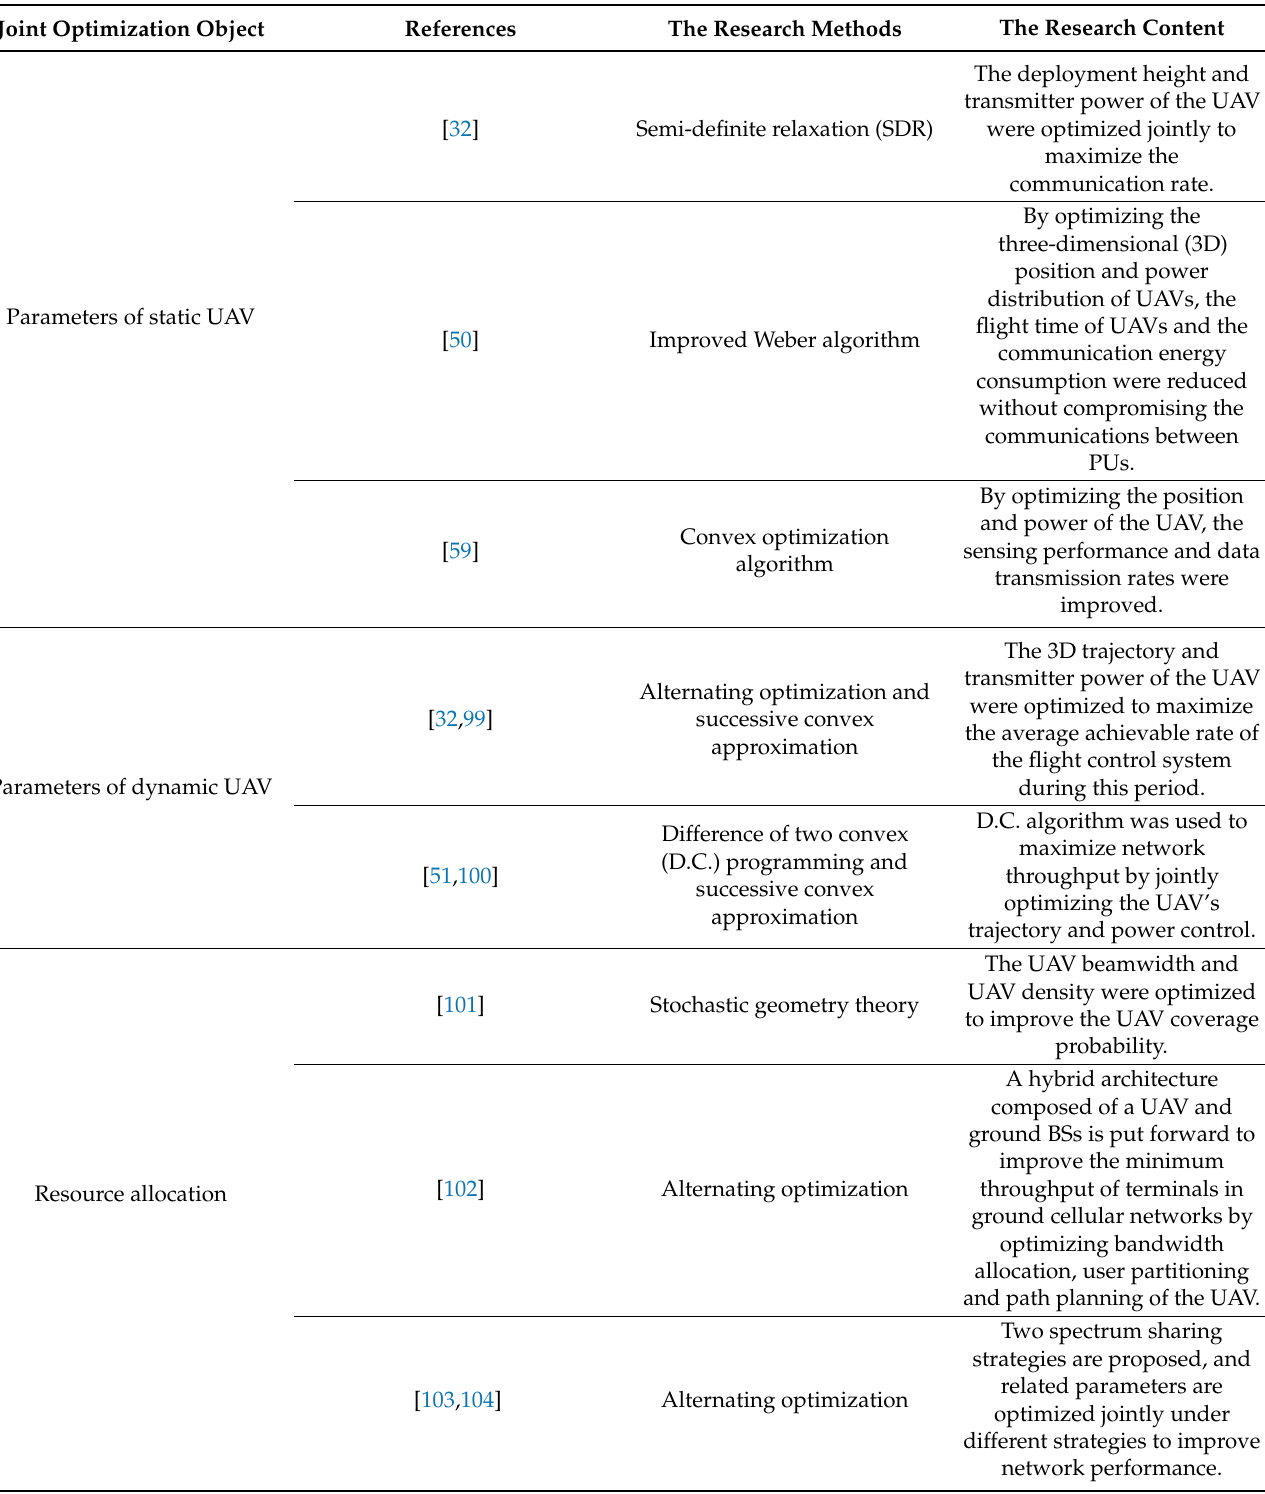
Table 10. Reference related to performance optimization of